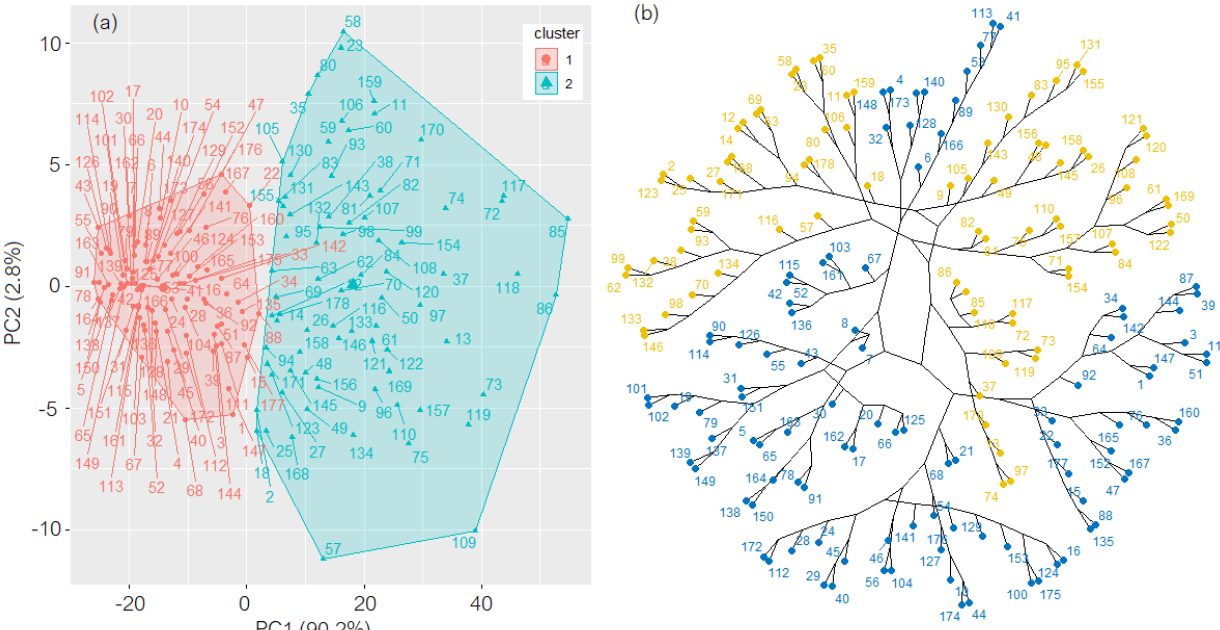
Figure 5. ( a ) Clusters (the values on the axes represent the scores on PC2 and PC1) and ( b ) the dendrogram from the hierarchical clustering of TITS. The elements in different clusters are in different colors.